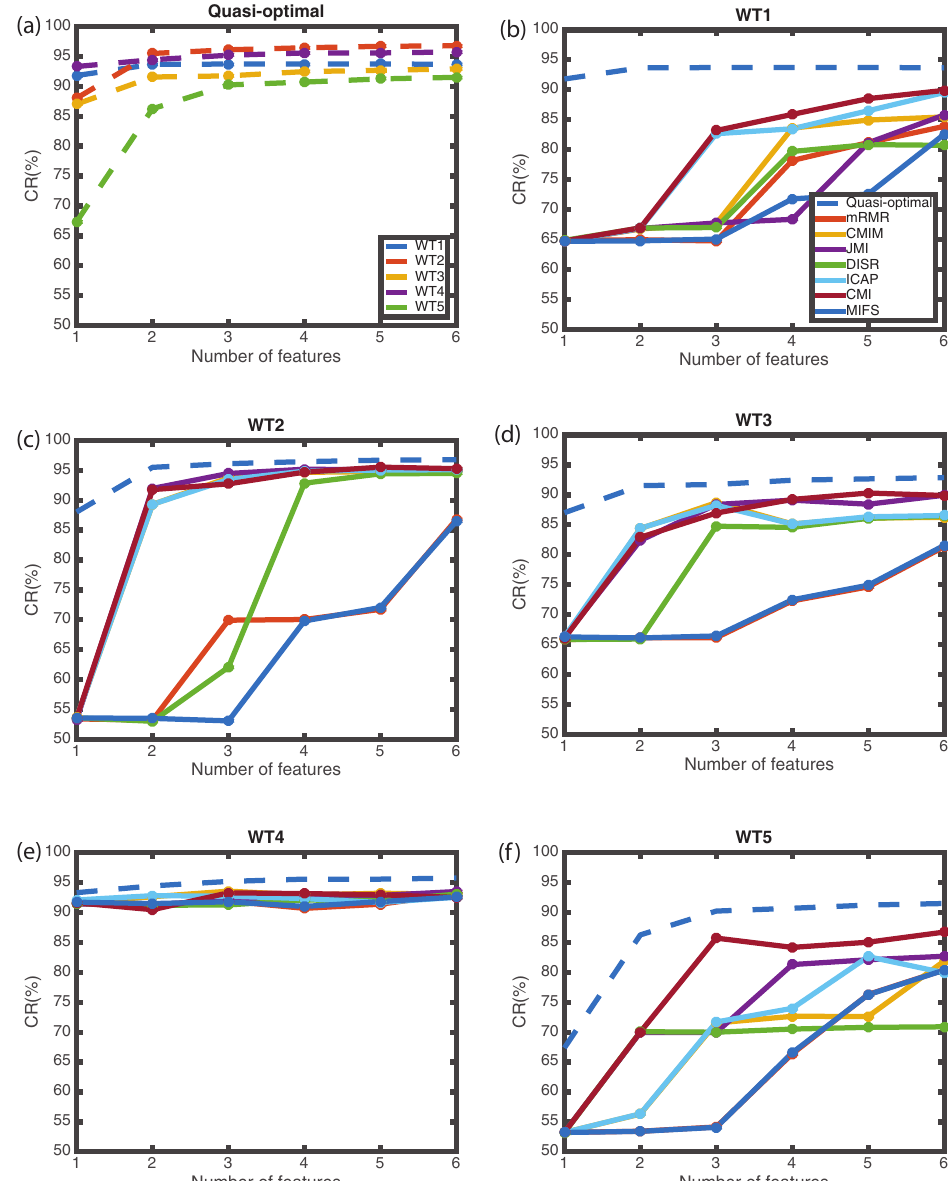
Figure 4. Evolution of the CR(%) against the number of features. ( a ) Quasi-optimal feature selection algorithm, all WT. ( b – f ) Specific results for each WT and all the automatic feature selection algorithms analyzed. The dashed line in each panel corresponds to the quasi-optimal result for that specific